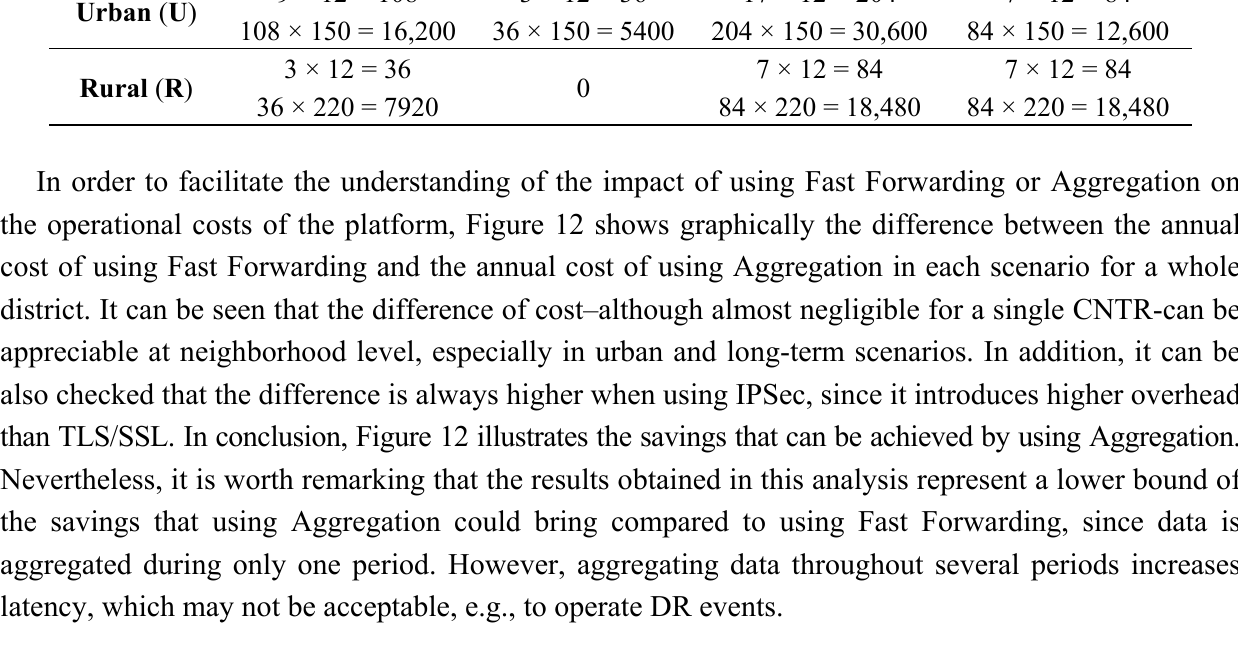
Figure 12. Annual savings of using Aggregation compared to Fast Forwarding | – C | ) per district for each security protocol in each (C S FF S Aggr